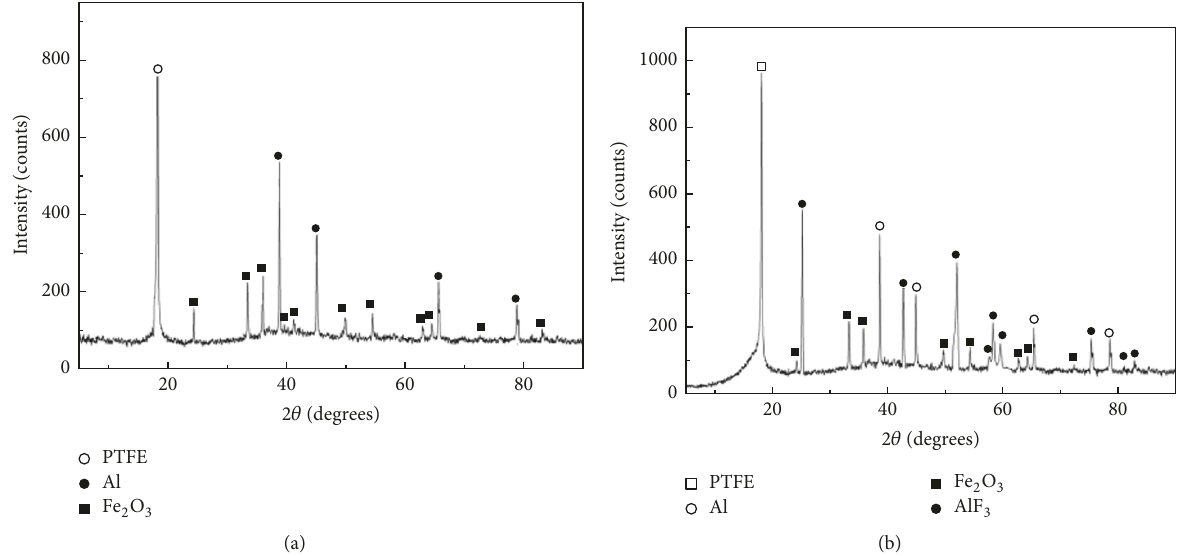
Figure 7: The XRD results of specimens after quasi-static compression. (a) Type A specimen and (b) type B specimen.